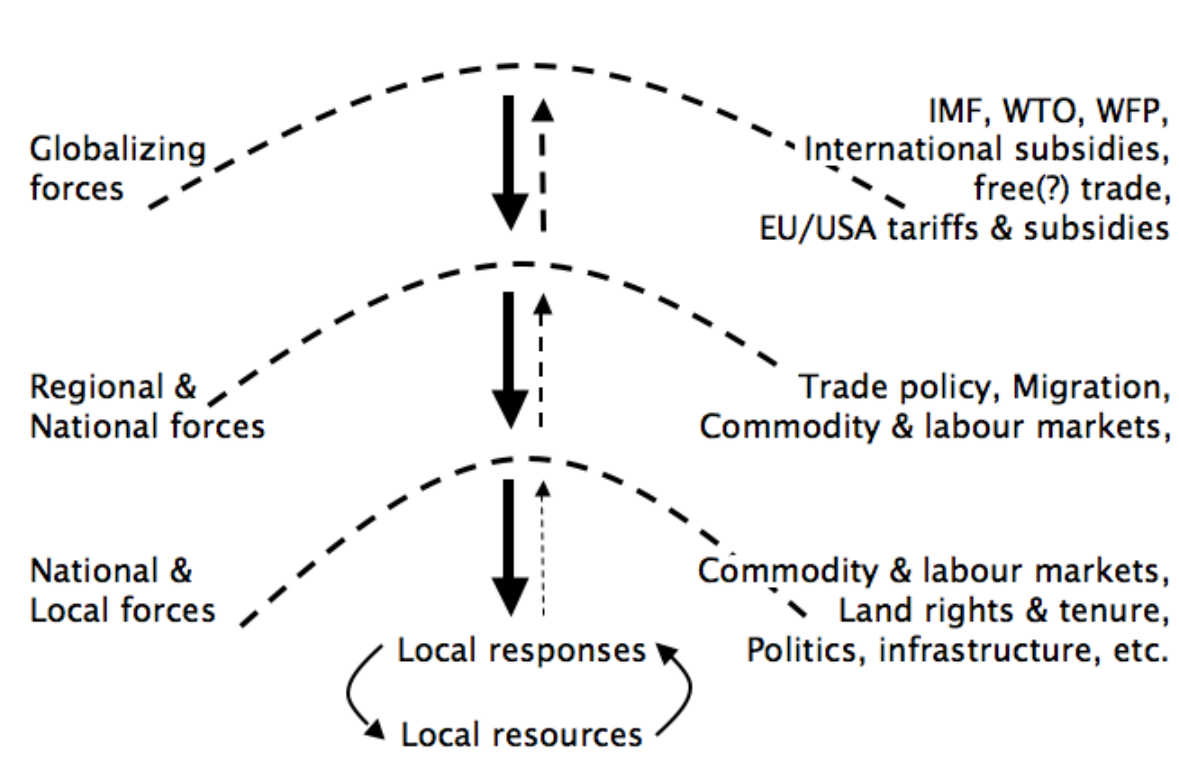
Fig. 1. Global and national policies structure the space within which local responses can be generated. Local “innovations” or responses depend largely on available local resources, but are constrained or enabled by policies and regulations at higher levels. Alleviating constraints at only the national or local level may have no beneficial effect if constraints at the regional or international level are not addressed. The feedback or influence from the local level to higher levels is often very weak, whereas influences from national to regional and global levels are often stronger. A key aim of analysis is to identify enabling policies that can create a greater space for local innovative responses, and strengthen local communities’ influence at higher